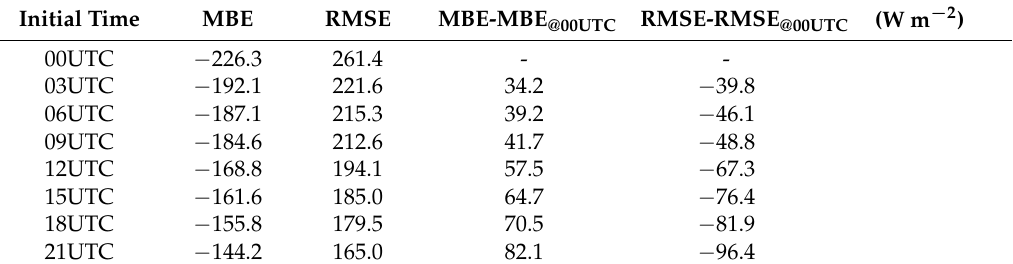
Figure 11. ( a ) Weather chart at 09 JST on 11 July 2017. ( b ) Time series of hourly GHI observations (black circles), meso-scale model (MSM) forecasts (colors), and extra-terrestrial solar irradiance on the same day for the integrated region of the nine electric power companies’ areas. Table 9. Same as Table 6, but for 11 July 2017.